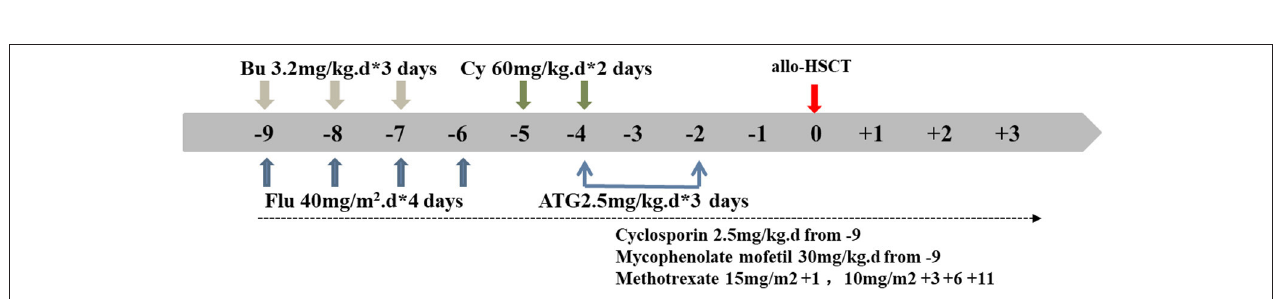
FIGURE 3 | Conditioning regimen schedule. Days (d) are numbered with respect to the day of transplantation (day 0). Bu, busulfan; Flu, fludarabine; Cy, cyclophosphamide; ATG, antithymocyte globulin; allo HSCT, allogeneic hematopoietic stem cell transplant.